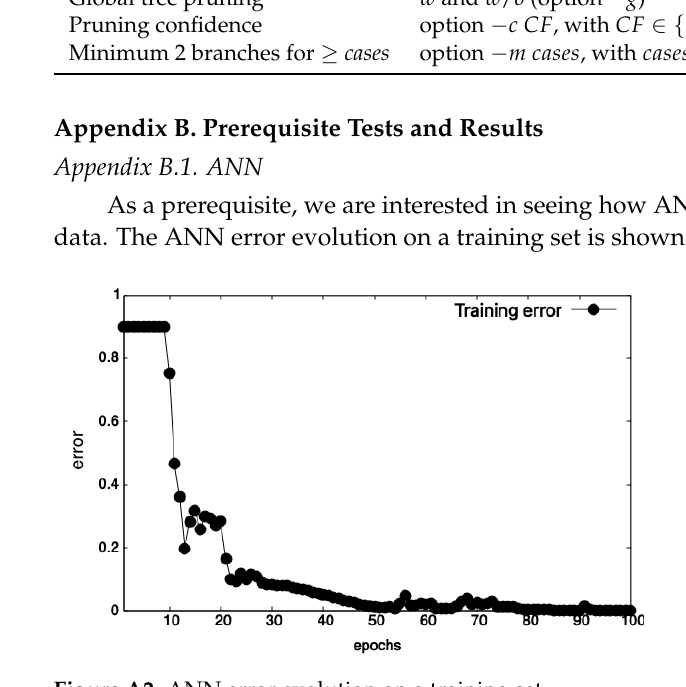
Figure A2. ANN error evolution on a training